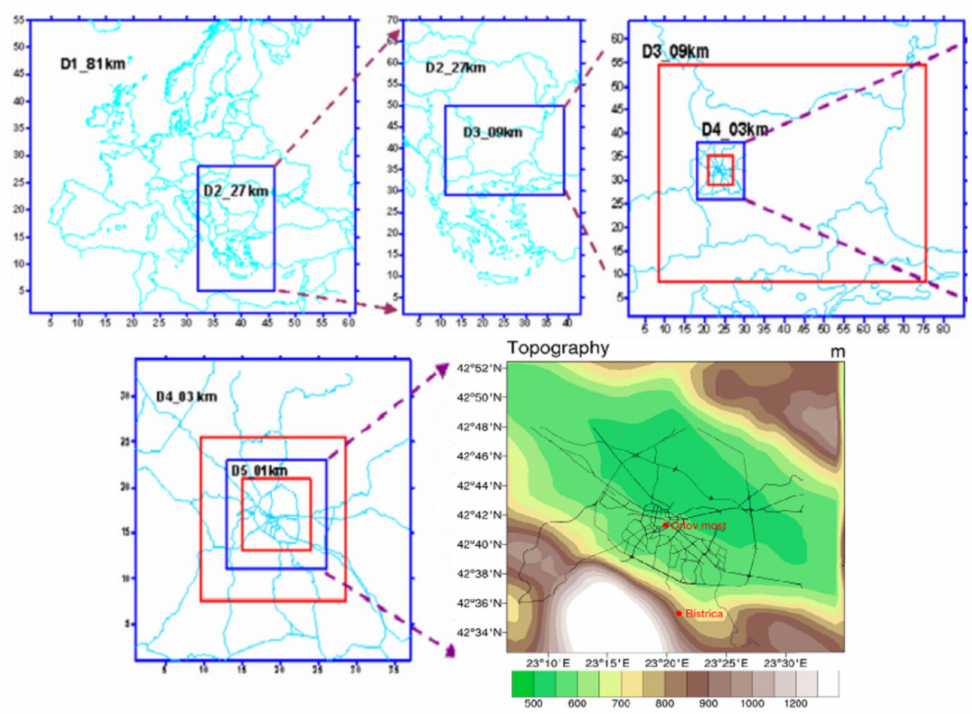
Figure 1. Five computational domains (CMAQ domains are nested in WRF ones)—D1 81 × 81 km (Europe), D2 27 × 27 km (Balkan Peninsula), D3 9 × 9 km (Bulgaria), D4 3 × 3 km (Sofia municipality) and D5 1 × 1 km (Sofia